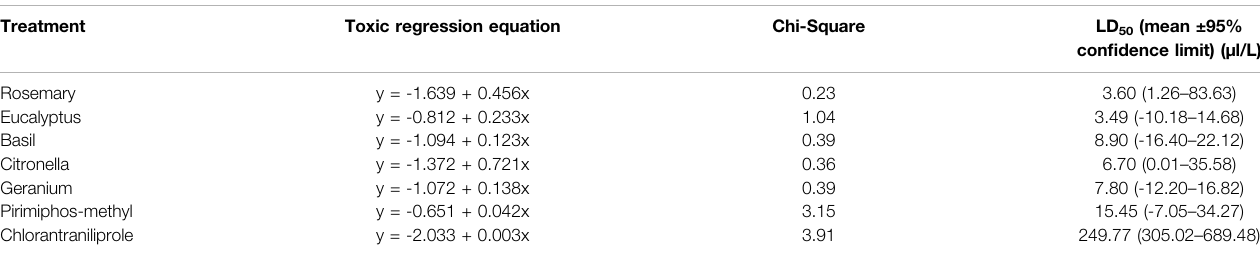
TABLE 2 | Contact activity of fi ve kinds of plant essential oils against L. serricorne adults. Essential oil